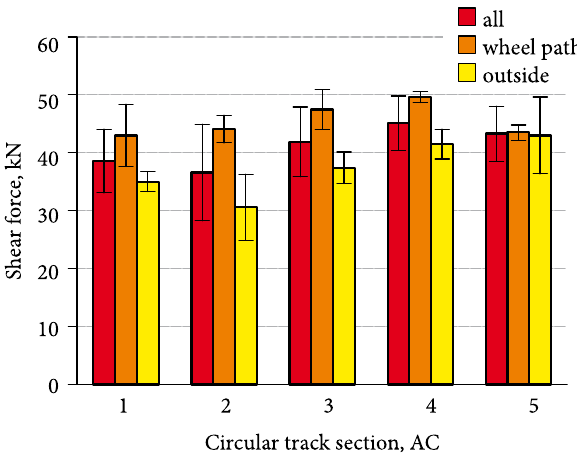
fig. 7. LPDS test results at 20 °C for the circular track, mean values and standard deviation